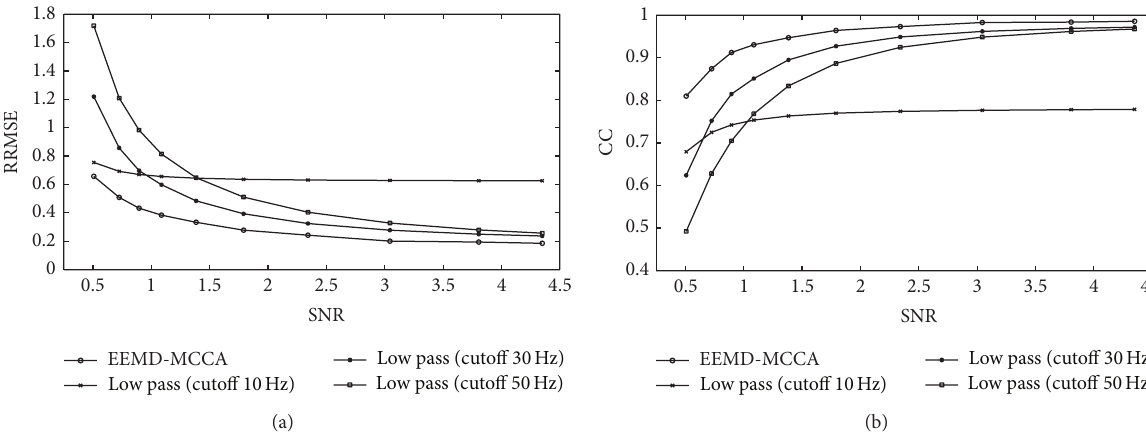
Figure 6: The performance comparisons between EEMD-MCCA and low-pass filters at various SNR values in terms of two criteria: (a) RRMSE and (b) CC.